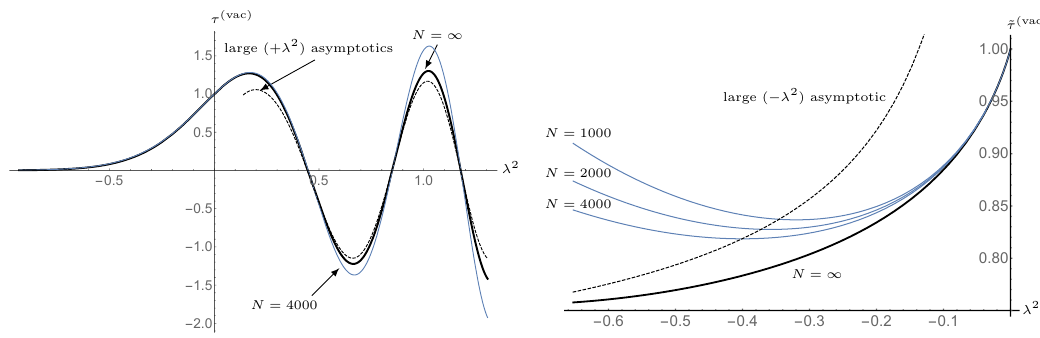
(cid:0) (cid:1) 2 (cid:25) ( (cid:0) (cid:21) 2 ) 3 2 is plotted